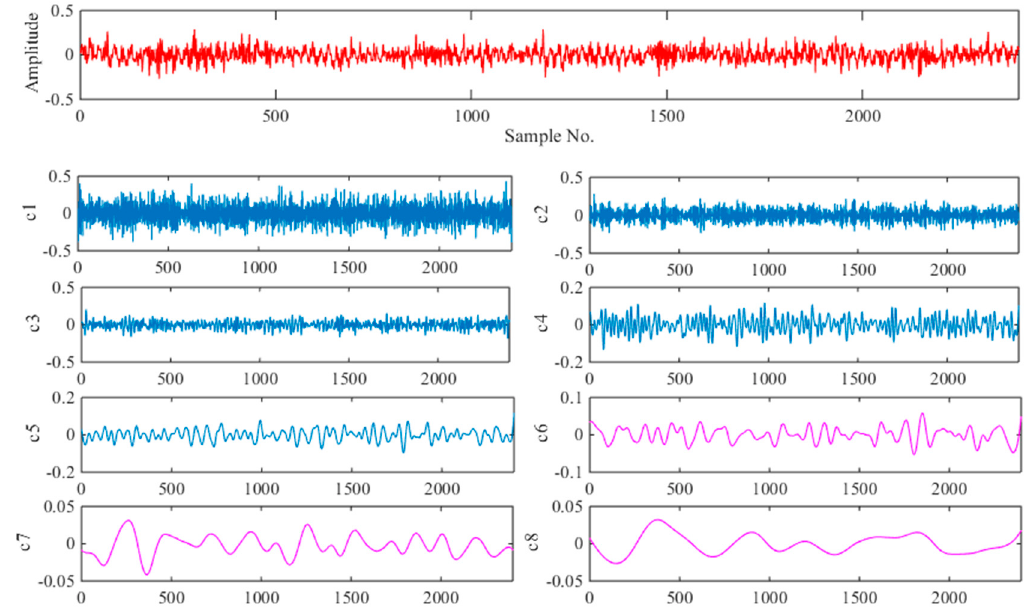
Figure 10. Decomposed signal in normal working condition using EEMD.